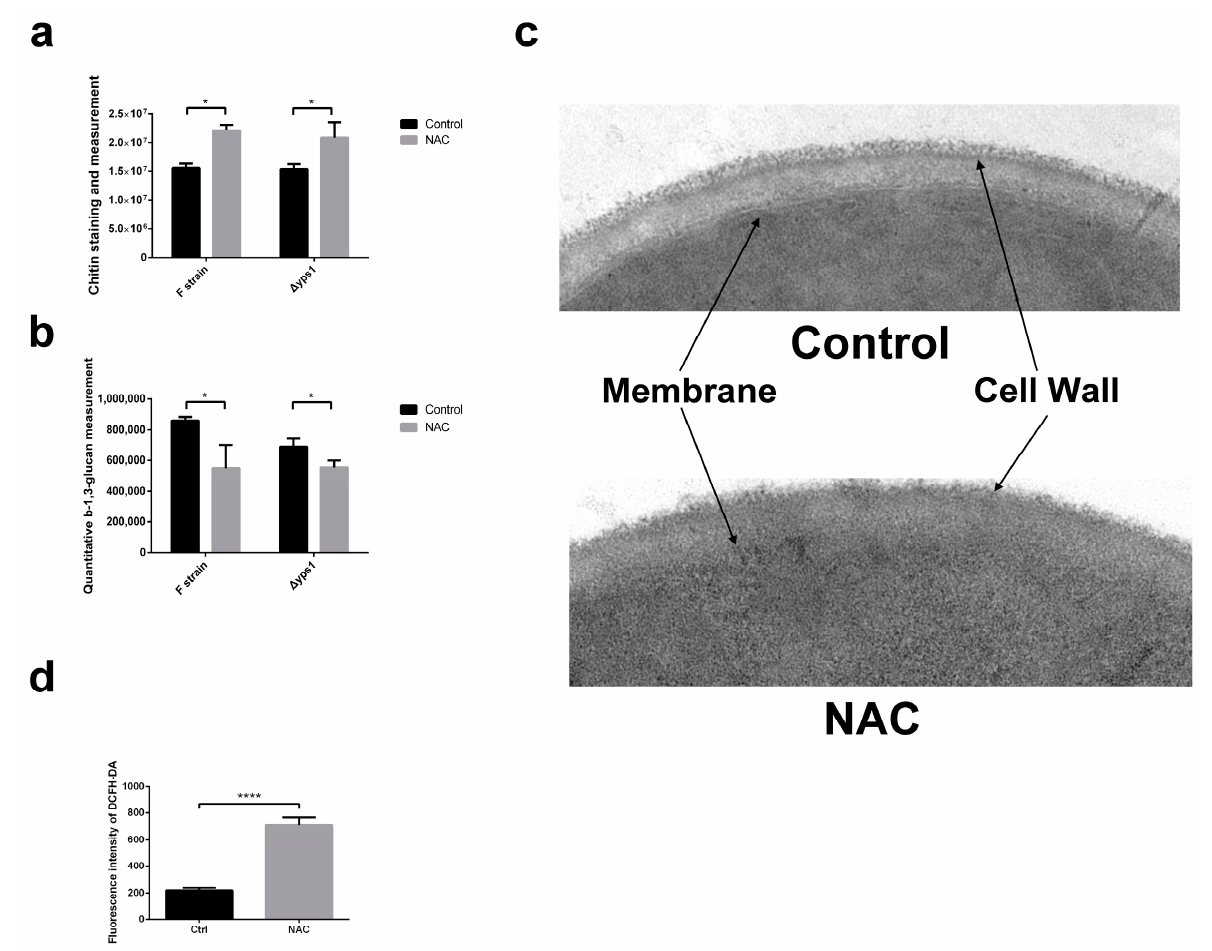
Figure 2. E ff ect of NAC on the cell wall composition. ( a ) Chitin staining and measurement. F and ∆ yps1 strains dealt with or without NAC were collected by centrifugation at 3000 × g for 5 min, and cells were stained with 20 µ g/mL CFW. ( b ) Quantitative β -1,3-glucan measurement. The β -1,3-glucan content in the cell wall was measured with aniline blue. ( c ) Transmission electron microscopy (TEM) of the F strain treated with 5 mM NAC for 72 h. CW: cell wall, Mem: cell membrane. ( d ) Total ROS levels of 5 × 10 7 cells were measured with 2 (cid:48) ,7 (cid:48) -dichlorofluorescin diacetate (DCFDA) reagent after 72 h of NAC treatment. Cells were collected and washed twice with PBS, and then incubated with BMMY containing 10 µ M DCFDA at 30 ◦ C. There were three repeats for each group, and p values were calculated using Student’s two-tailed t -test with p < 0.05 considered statistically significant (Marked with *), and **** represent extremely significant difference ( p < 0.01). Error bars represent means ± standard deviation (SD) (n = 3).